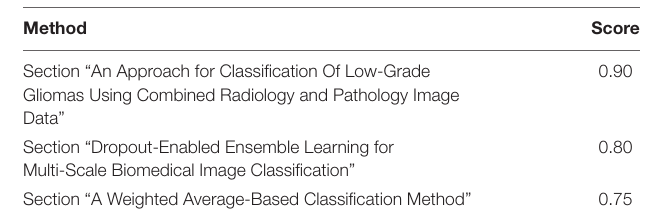
TABLE 1 | Accuracy scores of the classification methods presented in Section “Methods for Classification of Brain Cancer